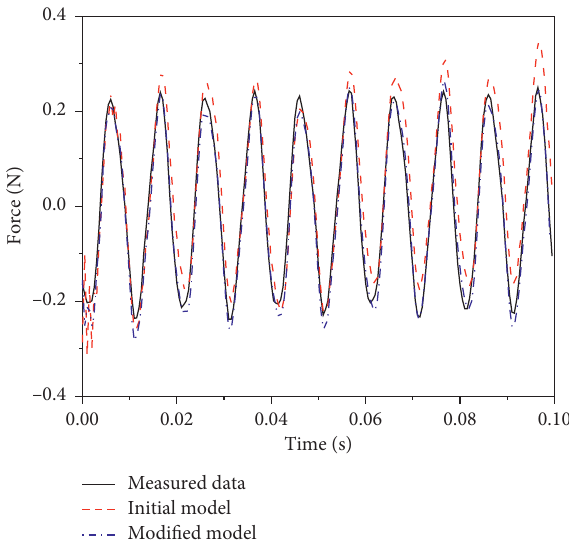
Figure 12: Comparison of results after modified finite element